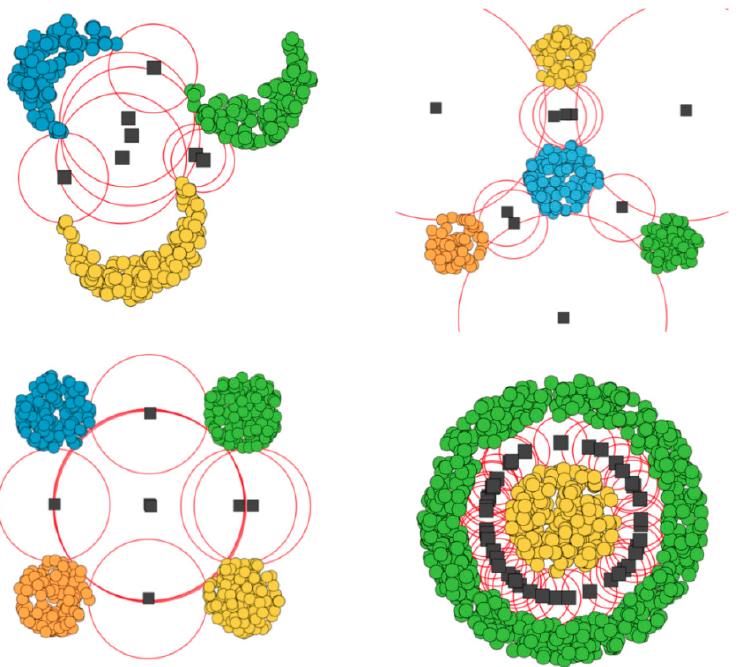
Figure 3. Screenshots of the discovered ignorance zones for the artificial datasets in 2D using Ga- briel neighbors. Gabriel